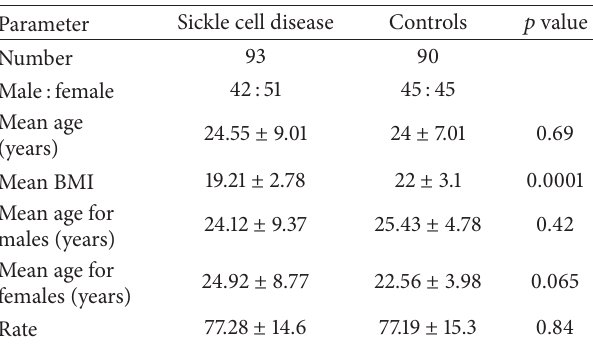
Table 1: The demographic